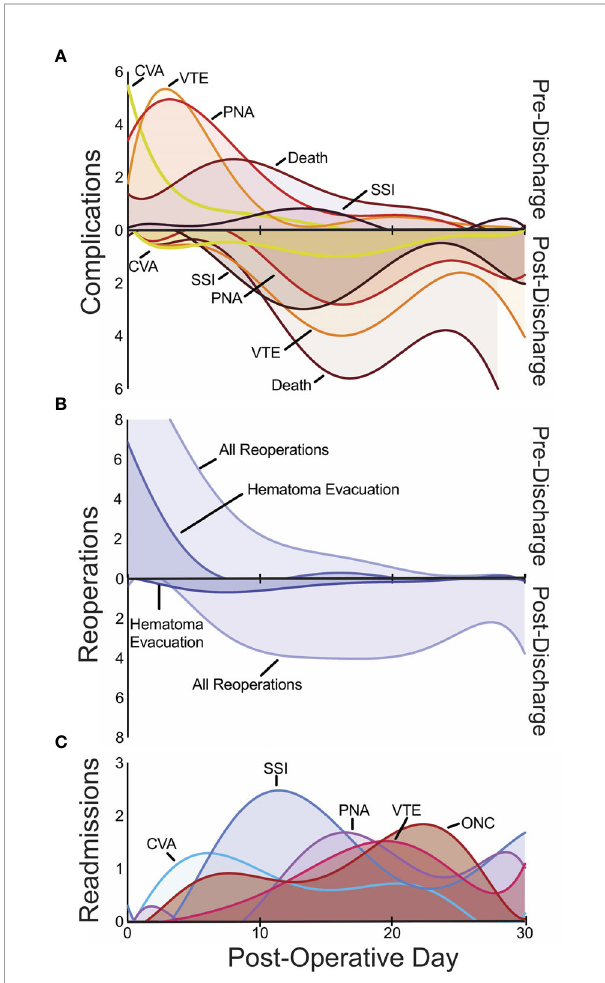
FIGURE 1 | Temporal patterns in 30-day pre- and post-discharge medical complications (A) , pre- and post-discharge reoperations (B) , and readmissions (C) with the day of the index operation de fi ned as post- operative day 0. CSF, cerebrospinal fl uid; CVA, cerebrovascular accident; ONC, medical oncologic admission; PNA, pneumonia; SSI, surgical site infection; VTE venous thromboembolism.